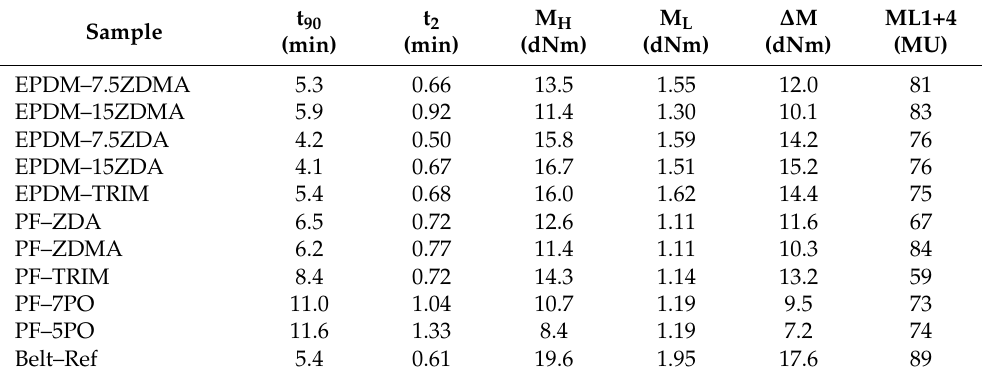
Figure 2. ( a ) Cross-linking rheograms, ( b ) stress–strain curves, ( c ) storage moduli versus tempera- ture, and ( d ) tan δ versus temperature of EPDM compounds with selected coagents. and ( d ) tan δ versus temperature of EPDM compounds with selected coagents. Table 3. MDR rheometer characteristics and Mooney viscosity of reinforced EPDM compounds under